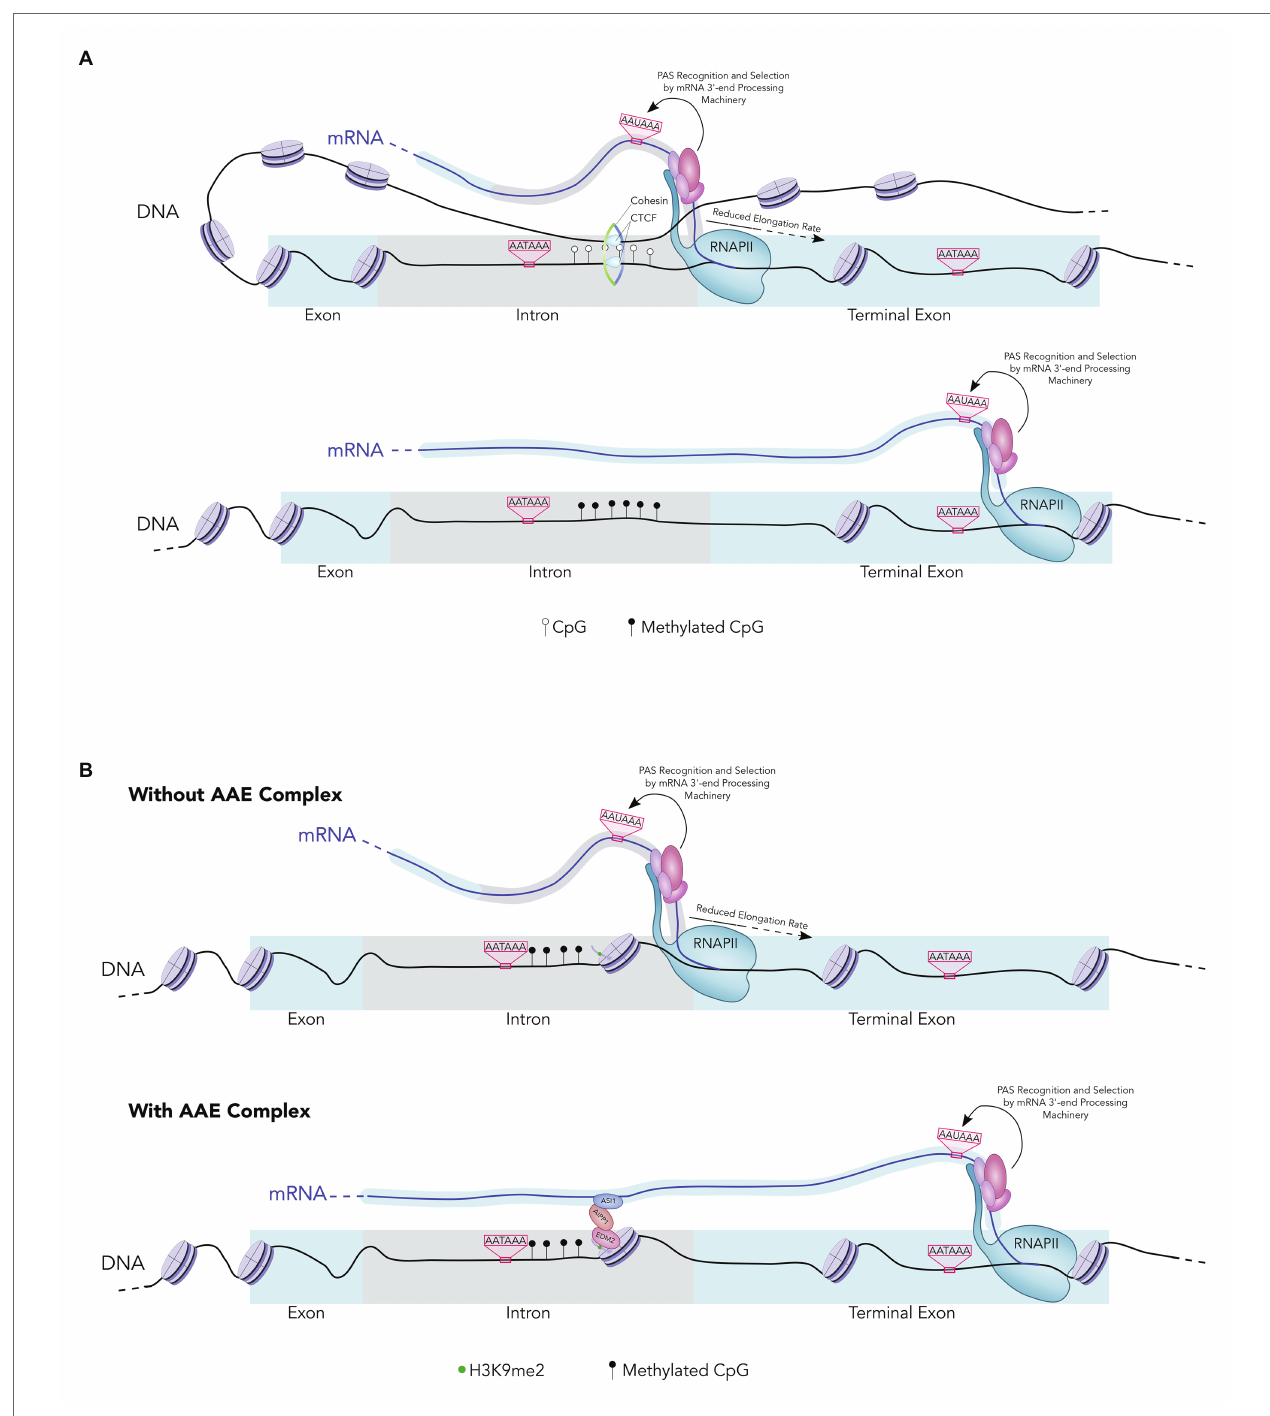
FIGURE 2 | (A) A model of APA regulation by DNA methylation. DNA is wrapped around nucleosomes (purple). In the top example, an unmethylated intronic CpG island allows the Cohesin-CTCF complex to bind downstream of an intronic PAS. The PAS are represented by AATAAA. Cohesin-CTCF binding to DNA forms a DNA loop and enhances RNA Polymerase II (RNAPII) pausing. This increases usage of the intronic PAS. In the bottom example, the intronic CpG island is highly methylated and the Cohesin-CTCF complex cannot bind. As a result, RNAPII does not pause downstream of the intronic PAS, the intron is removed by splicing, and the downstream PAS is selected in the terminal exon. (B) A model of APA regulation by the AAE complex. In the top example, intronic heterochromatin leads to RNAPII pausing in the absence of the AAE complex. This increases usage of the intronic PAS. In the bottom example, the AAE complex binds the heterochromatic region and counteracts the effects of heterochromatin on RNAPII pausing. RNAPII then transcribes the downstream PAS and this PAS is recognized and selected by the mRNA 3 ' -end processing